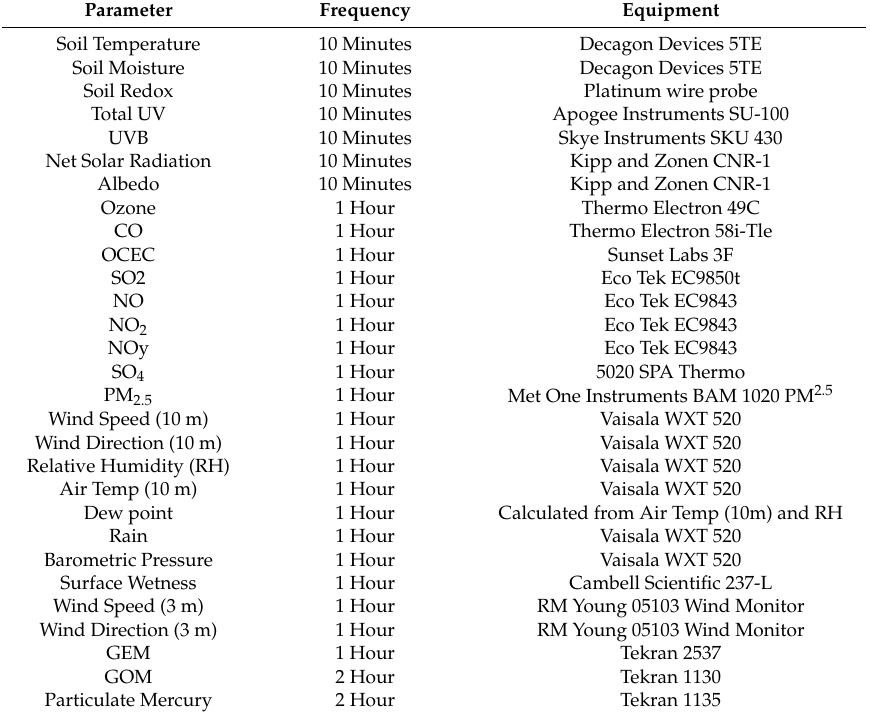
Table 1. Measurements made at